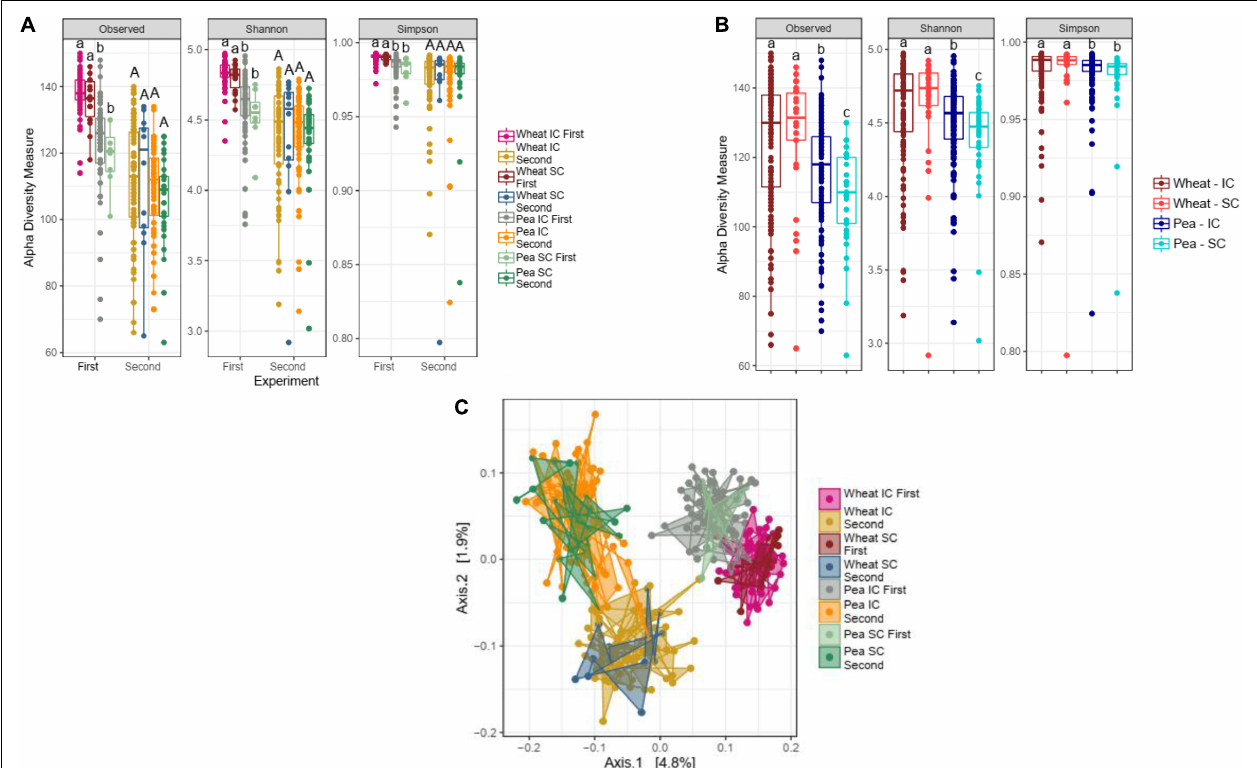
FIGURE 1 | Impact of the sole- (SC) and intercropping (IC) on rhizosphere microbiota. (A) Box-plots illustrate α -diversity indices (Observed, Shannon and Simpson) in bacteriobiota of wheat and pea cultivated in SC- and IC, in the first and the second experiment. Median values and interquartile ranges are indicated in the plots. Different letters indicate significant differences according to Wilcoxon-Mann-Whitney test. (B) Box-plots illustrate α -diversity indices (Observed, Shannon and Simpson) in bacteriobiome of wheat and pea cultivated in SC and IC, in a dataset pooling results from the two experiments. Median values and interquartile ranges are indicated in the plots. Different letters indicate significant differences according to Wilcoxon-Mann-Whitney test. (C) PCoA (with unweighted UniFrac), representing the β -diversity results of rhizosphere microbiota profiles of wheat and pea cultivated in sole- and intercropping, in the first and the second experiment.